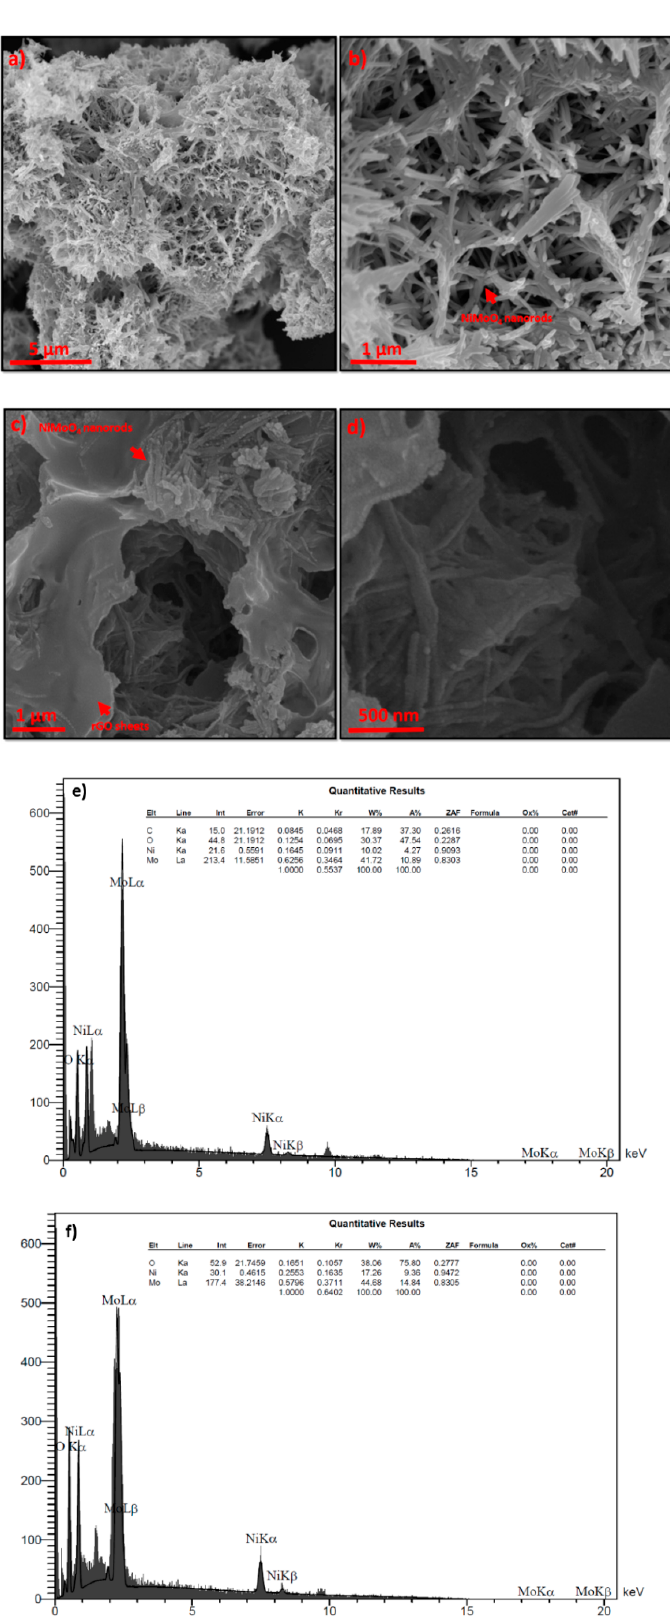
Figure 5. Scanning electron microscopy (SEM) images of ( a , b ) NiMoO 4 NPs with two different magnifications, ( c , d ) NiMoO 4 / 3D-rGO nanocomposite with various magnifications, ( e ) corresponding EDX spectra of NiMoO 4 / 3D-rGO, and ( f ) corresponding EDX spectra of NiMoO 4 .